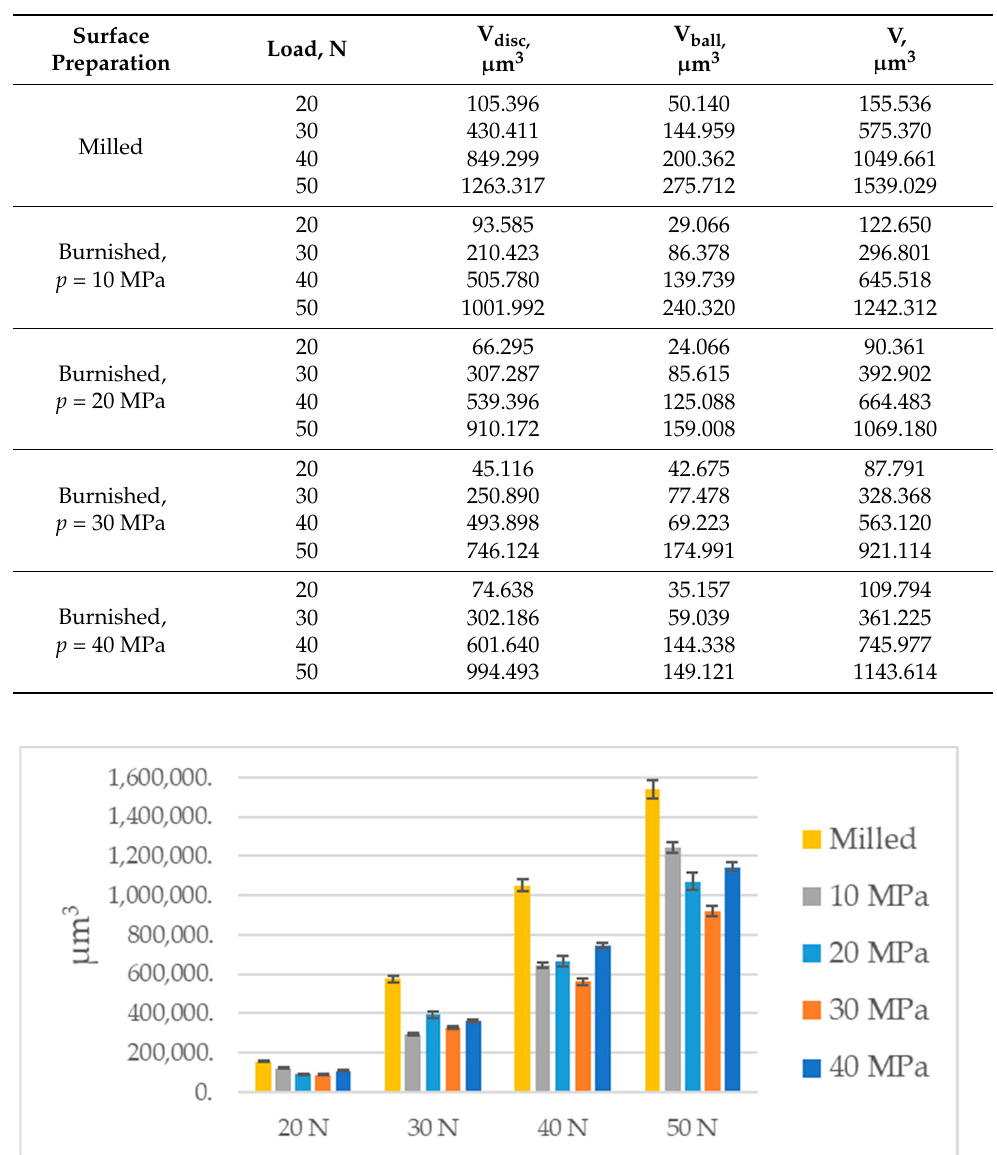
Figure 8. The results of wear examination of disc samples.